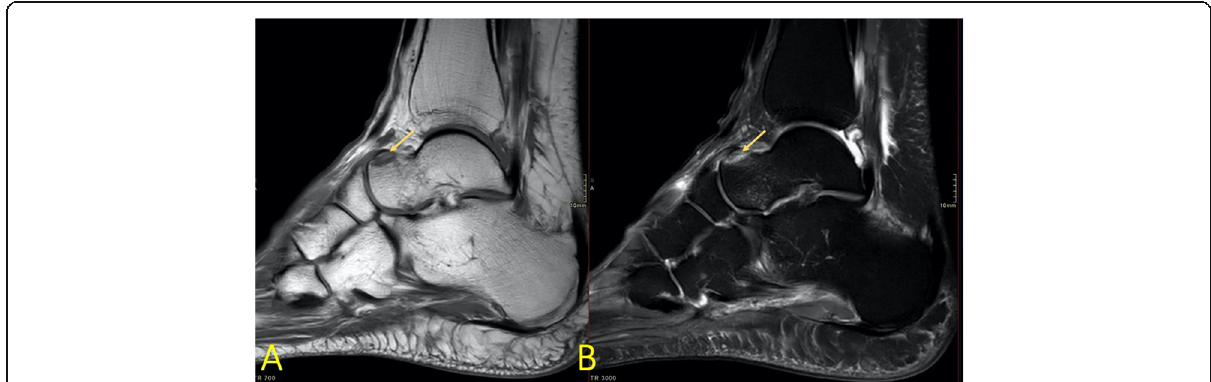
Fig. 4 A 19-year-old soccer player sustained an ankle sprain during a soccer match with suspicion of rupture of the anterior tibiofibular ligament. MRI showed avulsion (arrow) of the talar attachment of the dorsal talonavicular